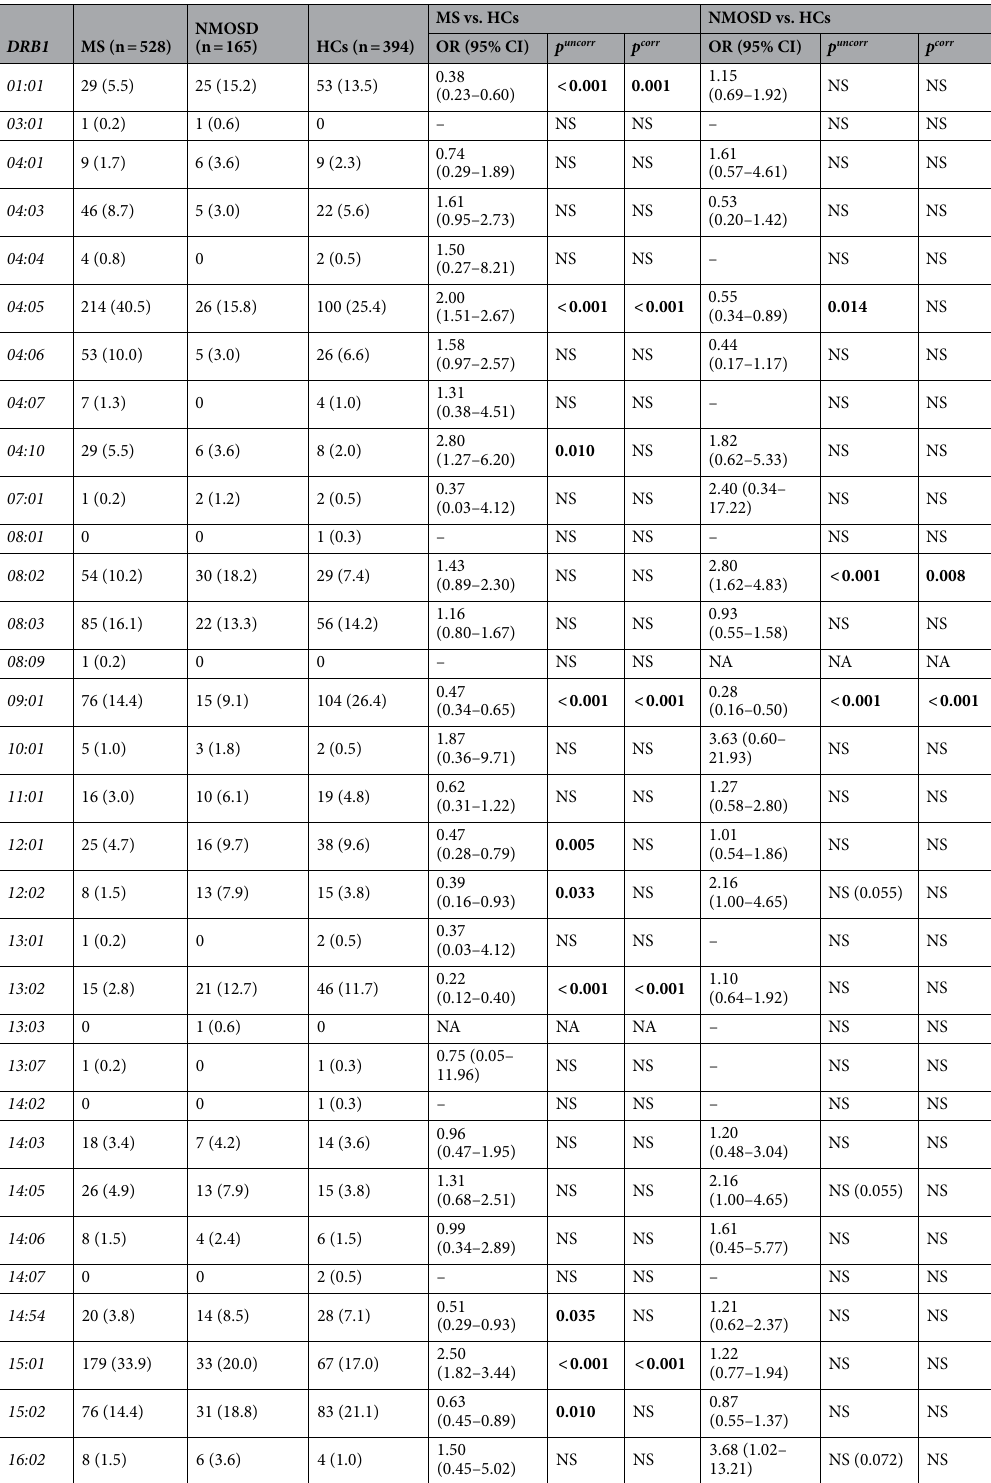
Table 2. Carrier frequencies of HLA-DRB1 in patients with MS and NMOSD and in healthy controls. Bold values indicate significant differences. Values are numbers (%). CI confidence interval, HC healthy control, MS multiple sclerosis, NA not applicable, NS not significant, OR odds ratio, p corr corrected p value, p uncorr uncorrected p